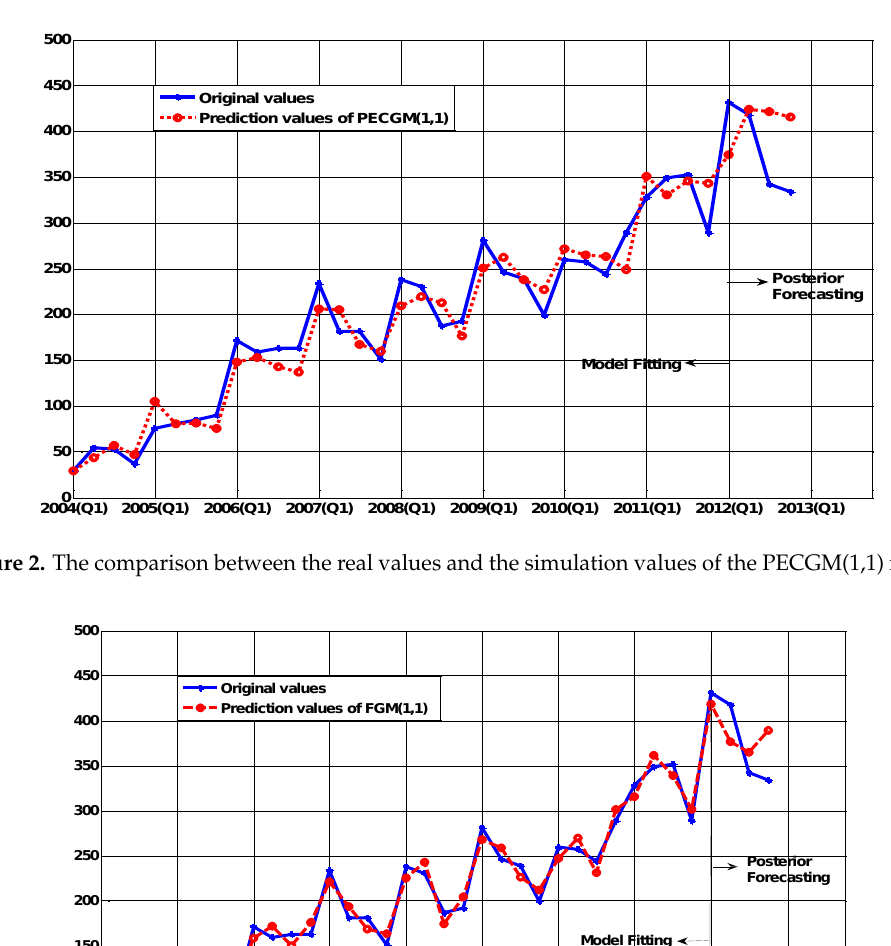
Figure 1. The comparison between the real values and the simulation values of the GM(1,1) model.